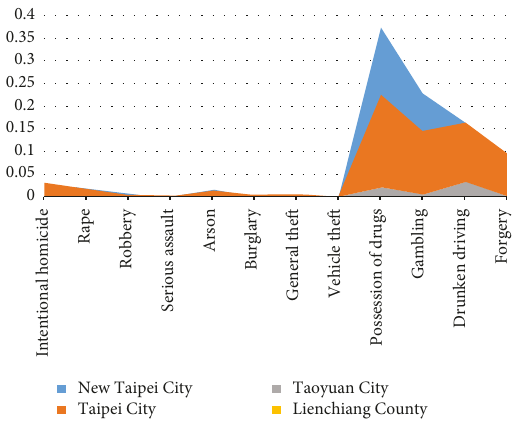
Figure 5: Crime data-related radar charts of cities and counties. Table 2: Overall public safety-related rankings of cities and counties in